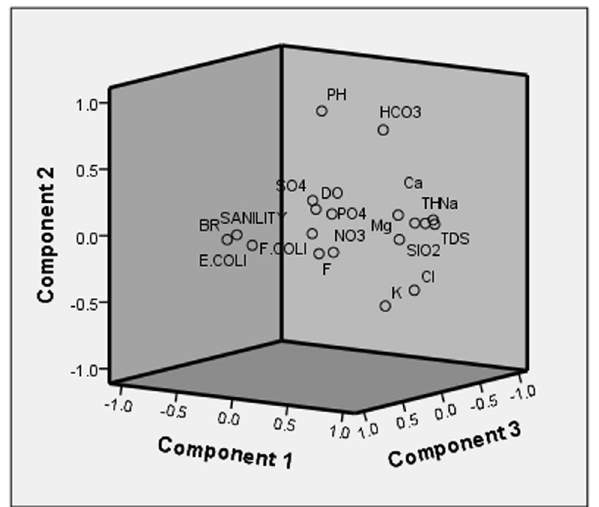
Fig. 4 Plot of components in rotated space to show their spatial rela- tions